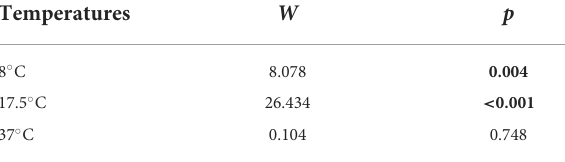
TABLE 3 Comparison of two cultivation designs (Experiment 1—cells were cultured immediately at test temperatures 8, 17.5, and 37 ◦ C